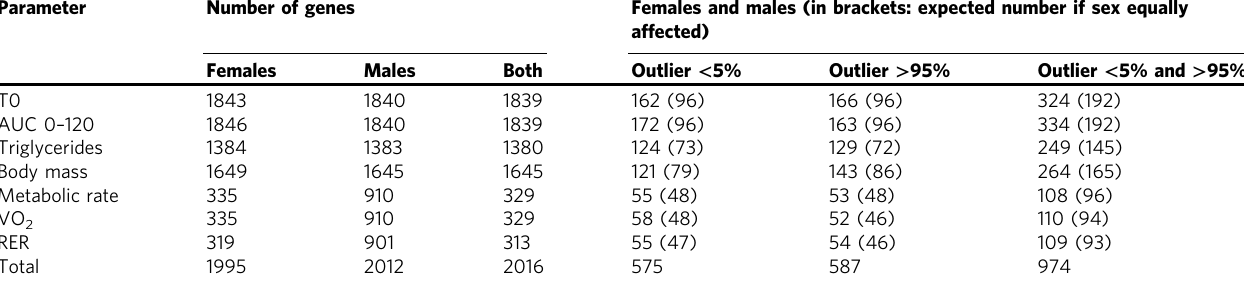
Table 1 Number of genes analyzed and candidate hits identi fi ed by phenotyping mutant and wild-type mice from both sexes Parameter Number of